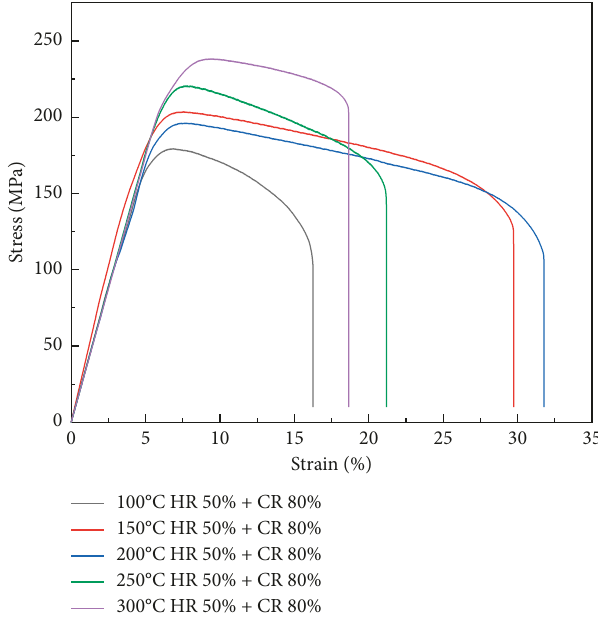
Figure 5: The stress-strain curves of the hot-rolling plus cold- rolling specimens under different temperatures. Table 1: Tensile testing values from Figure 5.